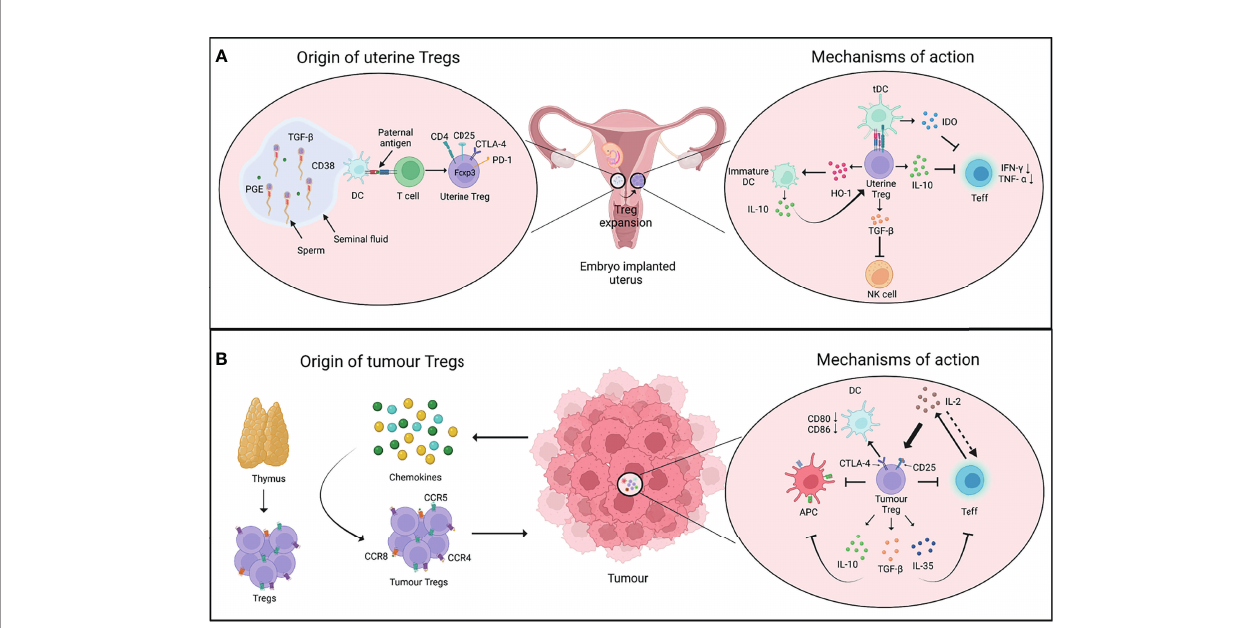
FIGURE 1 | Origin and mechanisms of Tregs in pregnancy and cancer. (A) After conception, the seminal fl uid encounters the uterine tissue. The presentation of paternal antigens by dendritic cells (DCs) to T cells as well as other soluble factors in the seminal fl uid favour the induction of regulatory T cells (Tregs). The uterine Tregs express markers such as CTLA-4, PD-1, and Foxp3, and expand locally in the endometrium during early pregnancy (left panel). Uterine Tregs express factors such as IL-10 which inhibits the proliferation and function of T effector cells (Teff); TGF- b which inhibits the function of cytotoxic natural killer (NK) cells; and HO-1 which maintains decidual DCs in an immature state. These immature DCs express higher levels of IL-10 that further supports the immune-suppressive phenotype of uterine Tregs. Tregs also induce the expression of IDO by tolerogenic DCs (tDCs) which inhibits Teff cell function (right panel). (B) Cells in tumour microenvironment release chemokines that recruit Tregs expressing chemokine receptors such as CCR4, CCR5 and CCR8. Tumour Tregs have thymic origin and interact with diverse cell types in the tumour microenvironment (left panel). IL-2 is produced by Teff cells, which is sequestered by Tregs as they constitutively express IL-2 receptor subunit CD25, thus decreasing the bioavailability of IL-2 to Teff cells and inhibiting their function. Tregs may control DCs ’ activity through CTLA-4-CD80/86 axis. Tregs also produce immunosuppressive cytokines such as IL-10, TGF- b , and IL-35 that further inhibit the function of Teff cells and antigen-presenting cells (APCs) (right panel). PGE, Prostaglandin E; TGF- b , Transforming growth factor- b ; HO-1, Heme oxygenase-1; IDO, Indoleamine 2,3-dioxygenase. Created with